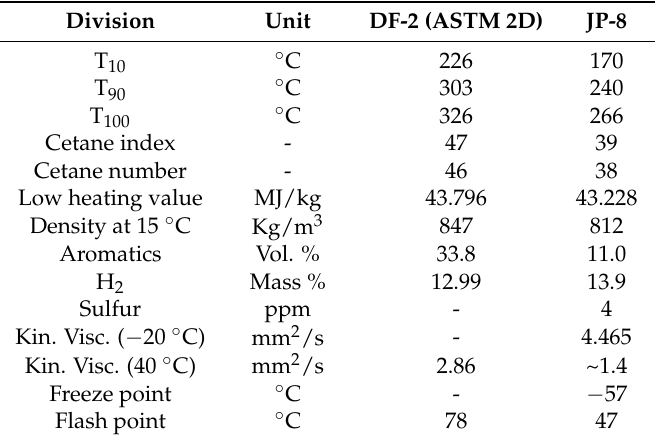
Table 1. Comparison of JP-8 (synthetic fuel and another fuel including diesel).